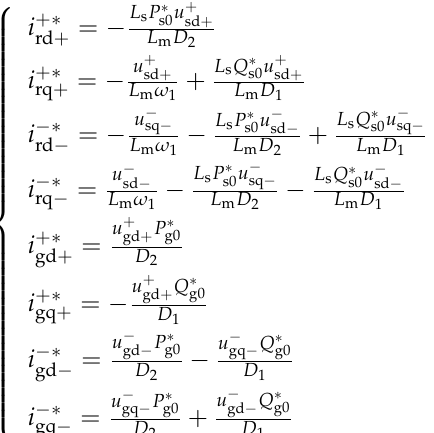
converter reactive